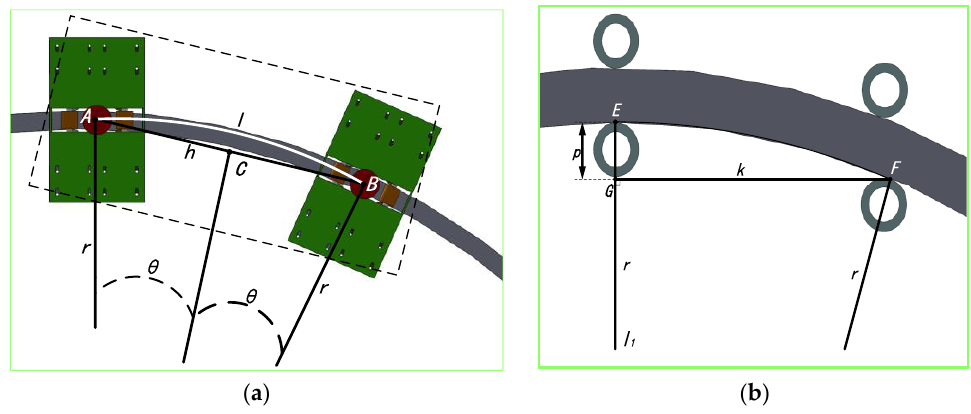
Figure 2. Turning diagrams . ( a ) Whole-car double-chassis turning ; ( b ) Single-chassis steering. There are two steering devices either side of the front and rear load-bearing wheels of a single chassis. The steering devices comprise steering wheels, gap-adjusting inter- plates, and stiff springs. The steering devices are transformed by the expansion and con- traction of the springs so that their guide wheels continuously fit on both sides of the track; i.e., the four guide wheels of a single chassis always fit on the track surface, as shown in Figure 2b. In the figure, point E is the tangent point between the rear guide wheel and the inner side of the track, and point F is the tangent point between the front guide wheel and the inner side of the track. The straight line l 1 connects point E and the center of the guide wheel. A horizontal line is drawn from point F to cross the line l 1 at point G. The distance